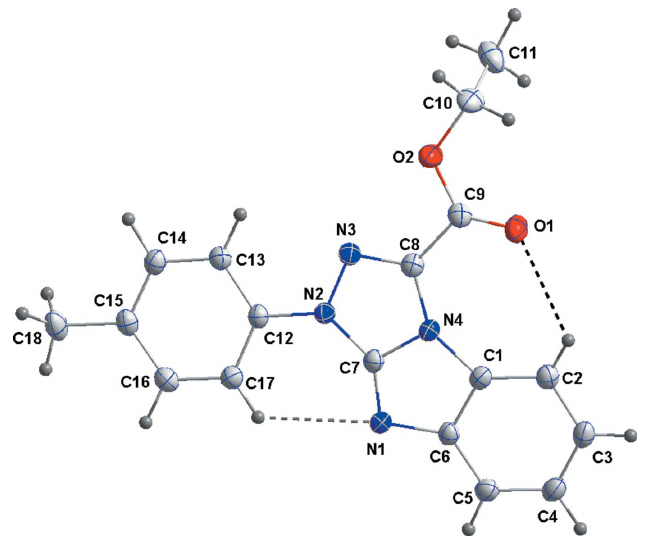
Figure 1 The title molecule with 50% probability ellipsoids. The intramolecular hydrogen bonds are shown as dashed